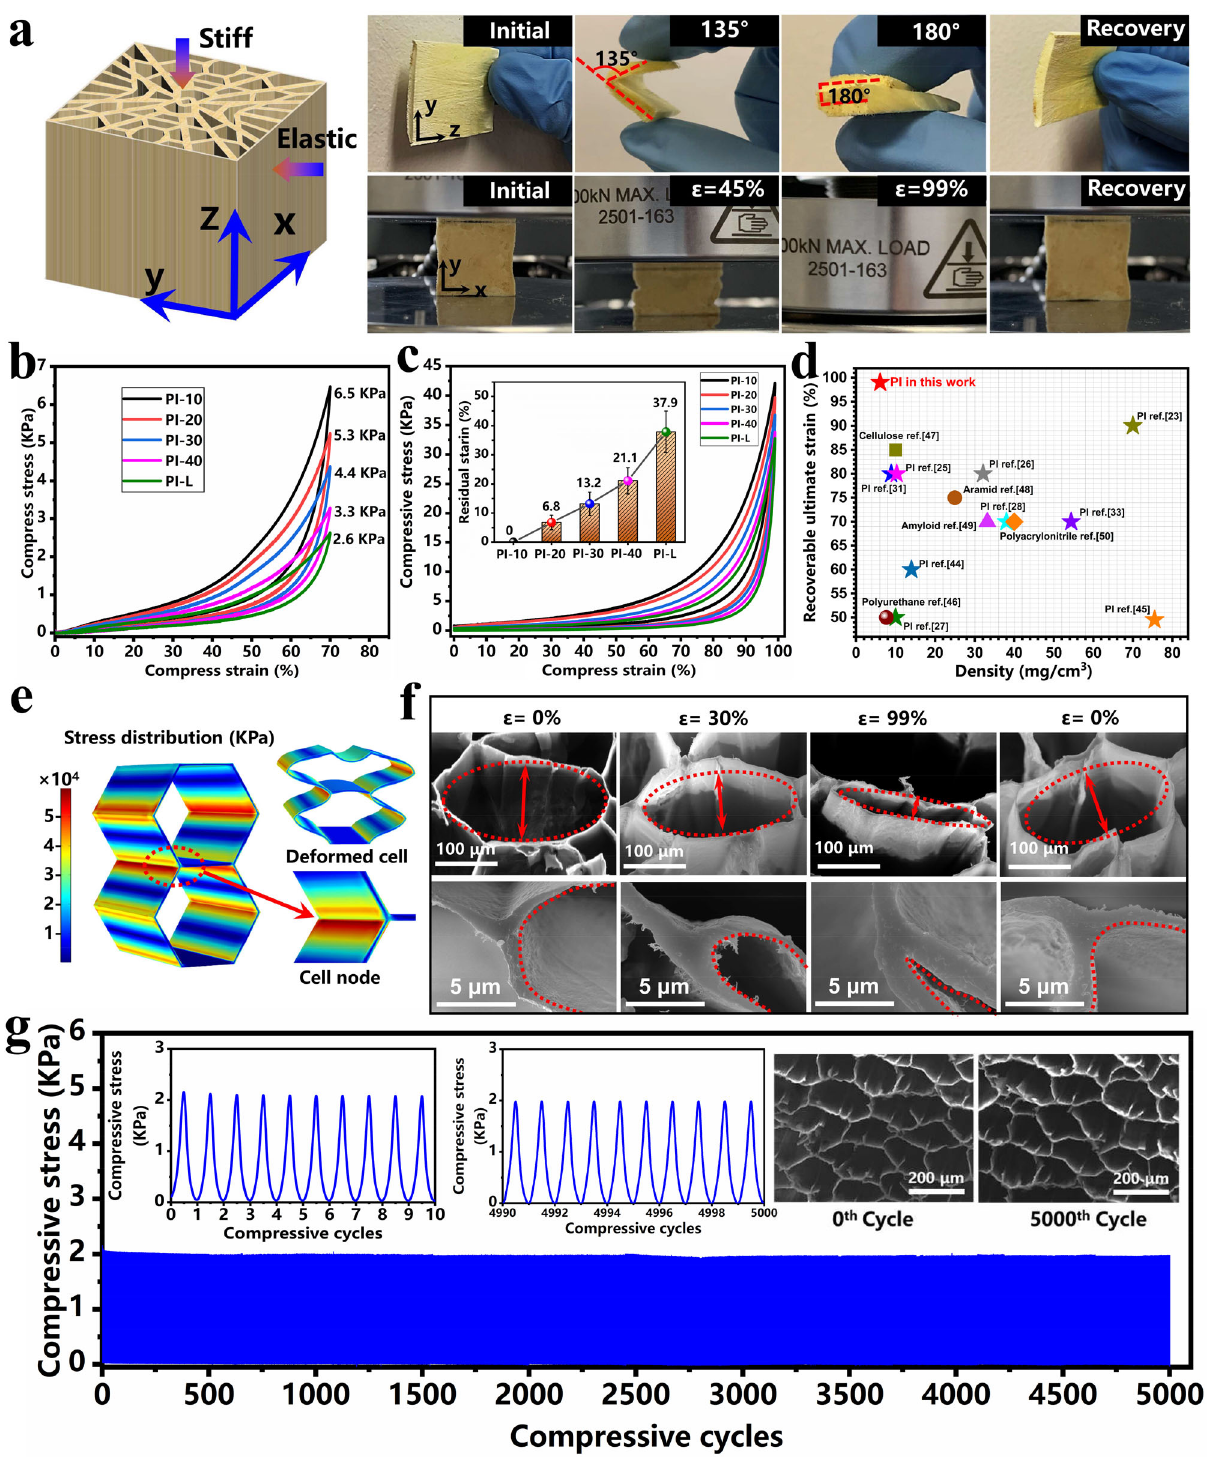
Fig. 4 Mechanical performance of PI aerogels. a Optical image of a PI aerogel ’ s recovery after 180° bending and 99% compression. b Compressive stress- strain curves with 70% strain of PI aerogels with different cross-linking degrees. c Compressive stress-strain curves with 99% strain and residual strain of PI aerogels with different cross-linking degrees. d Comparison of ultimate recoverable strains and densities of PI-10 aerogels with reported polymeric aerogels. e Simulated results of local stress distribution in cellular PI aerogels. f In-situ sequential SEM images of microstructure in PI-10 aerogels with different strains. g Fatigue test curves and SEM images of PI-10 aerogels before and after fatigue test of 5000